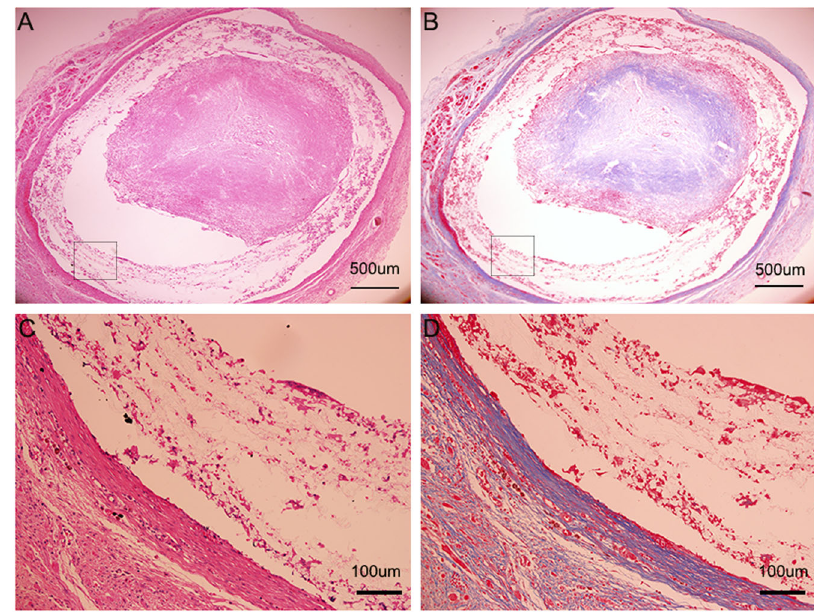
haematoxylin and eosin ( D ) (The scattered nucleus were shown by the arrow), Masson's trichrome ( E ) (The blue part indicated by the arrow was the collagen fi ber), Elastica van Giessen ( F ) (The white dotted areas indicated intimal hyperplasia)